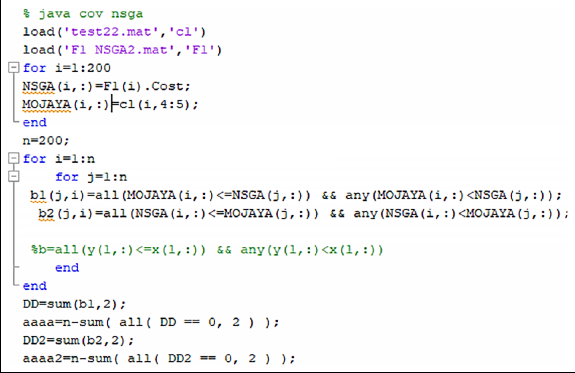
Figure 6. Coverage